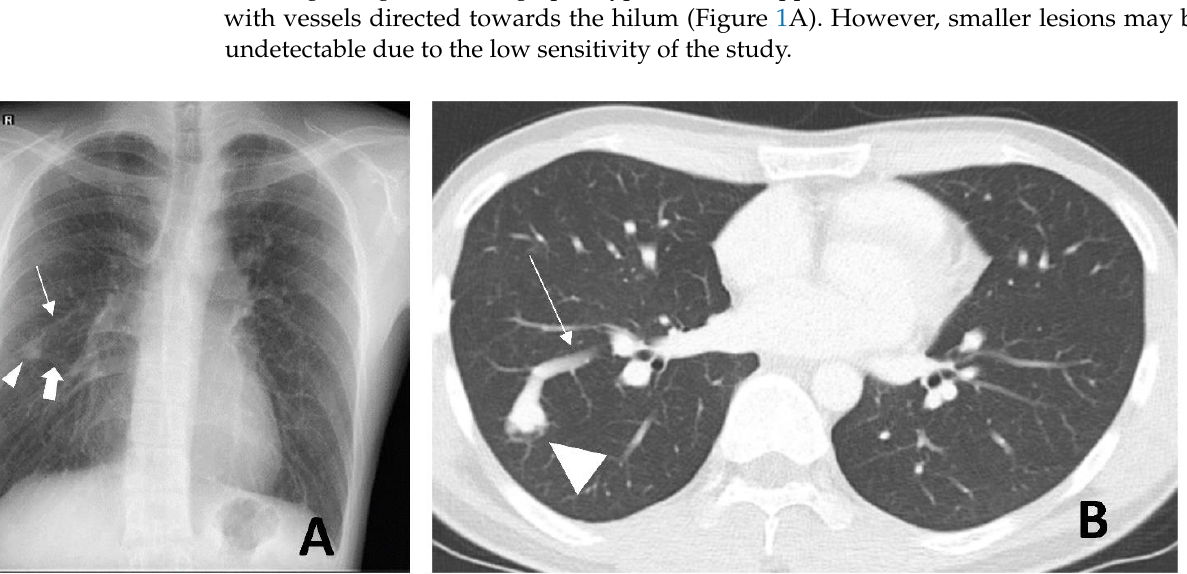
Figure 1. A 26-year-old male with a pulmonary arteriovenous malformation (PAVM) at the apical segment of the right lower lobe. Posterior–anterior chest radiograph ( A ) shows a right mid-zone pulmonary nodular opacity (arrowhead) with two cord-like structures arising from the medial margin of the lesion and directed toward the hilum. These are the feeding artery (thin arrow) and the draining vein (thick arrow). Axial contrast-enhanced computed tomography ( B ); lung window shows the same right lower lobe PAVM (arrowhead) with the partially-imaged feeding artery (thin arrow).